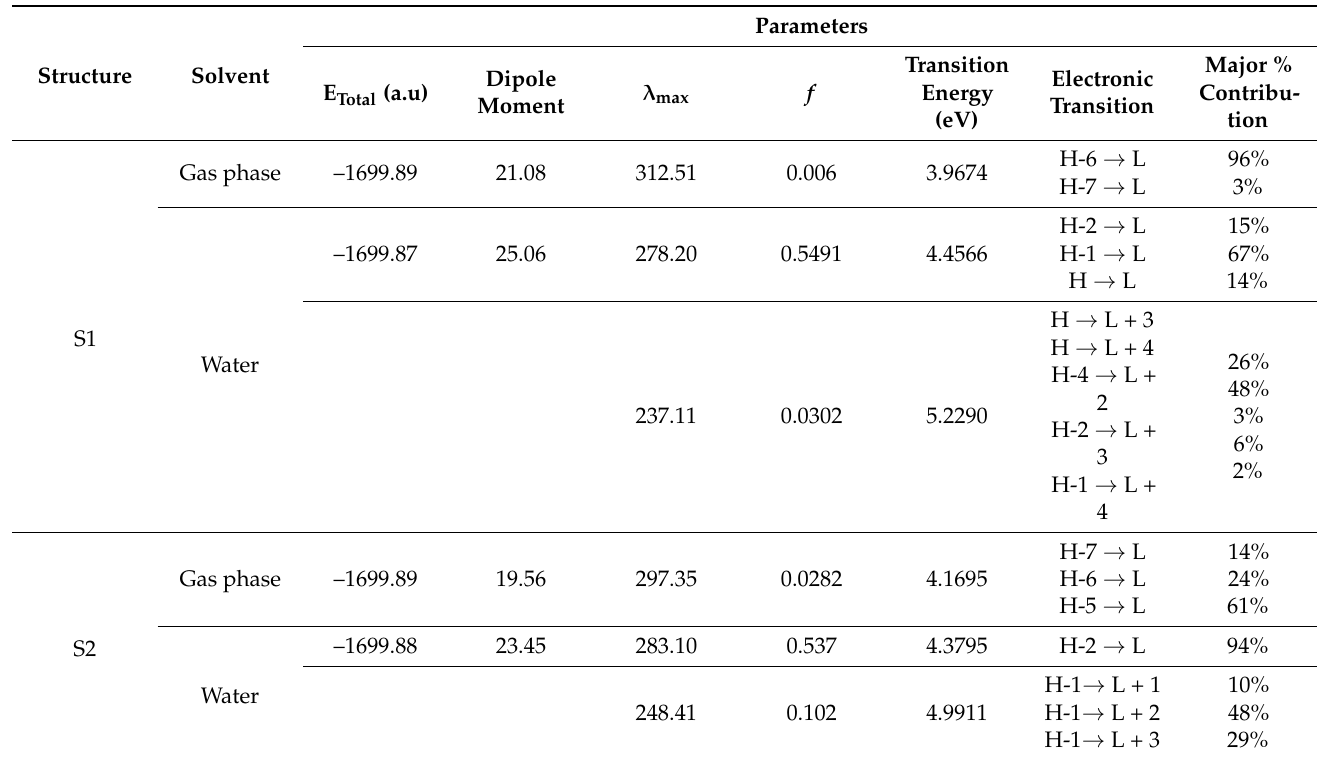
Table 3. Calculated energies, dipole moments (D), maximum absorption wavelengths ( λ max ), ex- citation energies (eV), oscillator strengths ( f ), assignment of electronic transitions (HOMO(H) → LUMO(L)), and major contribution (%) for the title compound S1 & S2 in gas phase